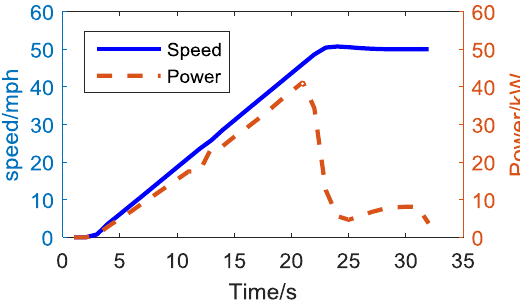
Figure 10. Speed and demanded power when accelerating.